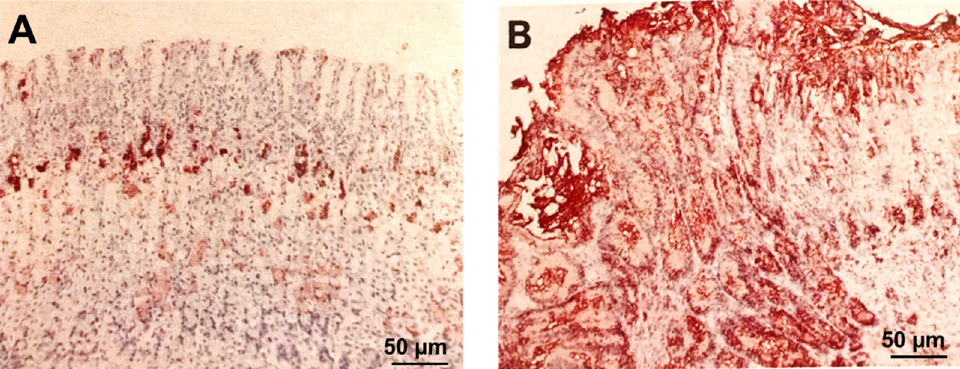
Figure 4. Photomicrographs of rat gastric oxyntic mucosa immunostained for epidermal growth factor receptor and counterstained with hematoxylin. ( A ) Normal rat gastric oxyntic mucosa shows epidermal growth factor receptor localization only in some neck cells of gastric glands (the progenitor zone; brown staining). ( B ) Mucosa at the GU margin 7 days after ulcer induction shows the “disappearance” of parietal and chief cells due to their dedifferentiation and reprogramming to progenitor cells (brown staining) through increased expression of epidermal growth factor receptors in the majority of cells lining GU margin. The cells demonstrating epidermal growth factor receptor expression occupy the entire mucosal thickness (reprinted with permission from [15]).